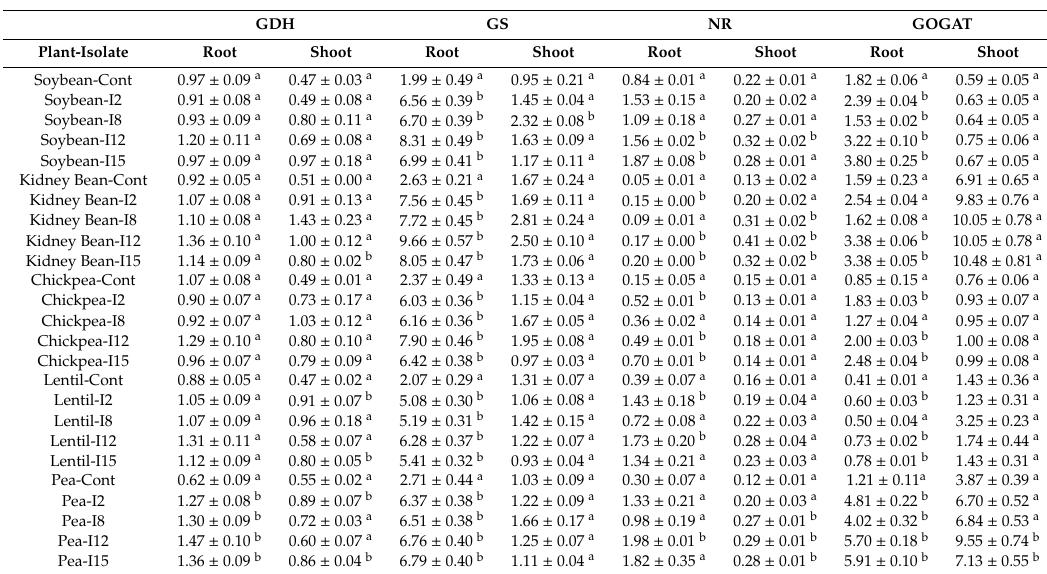
Table 2. Changes in the activity of nitrogen metabolizing enzymes glutamate dehydrogenase (GDH), glutamine synthetase (GS), nitrate reductase (NR), and glutamate synthase (GOGAT) expressed as units / mg protein in the shoots and roots of soybean, kidney bean, chickpea, lentil, and pea under control (cont.) and after enrichment with biologically active actinomycete isolates. Values are the average of three individual replicates (means ± S.D). Di ff erent letters represent significant di ff erences between the treatments in each crop (Duncan test; p < 0.05; n =